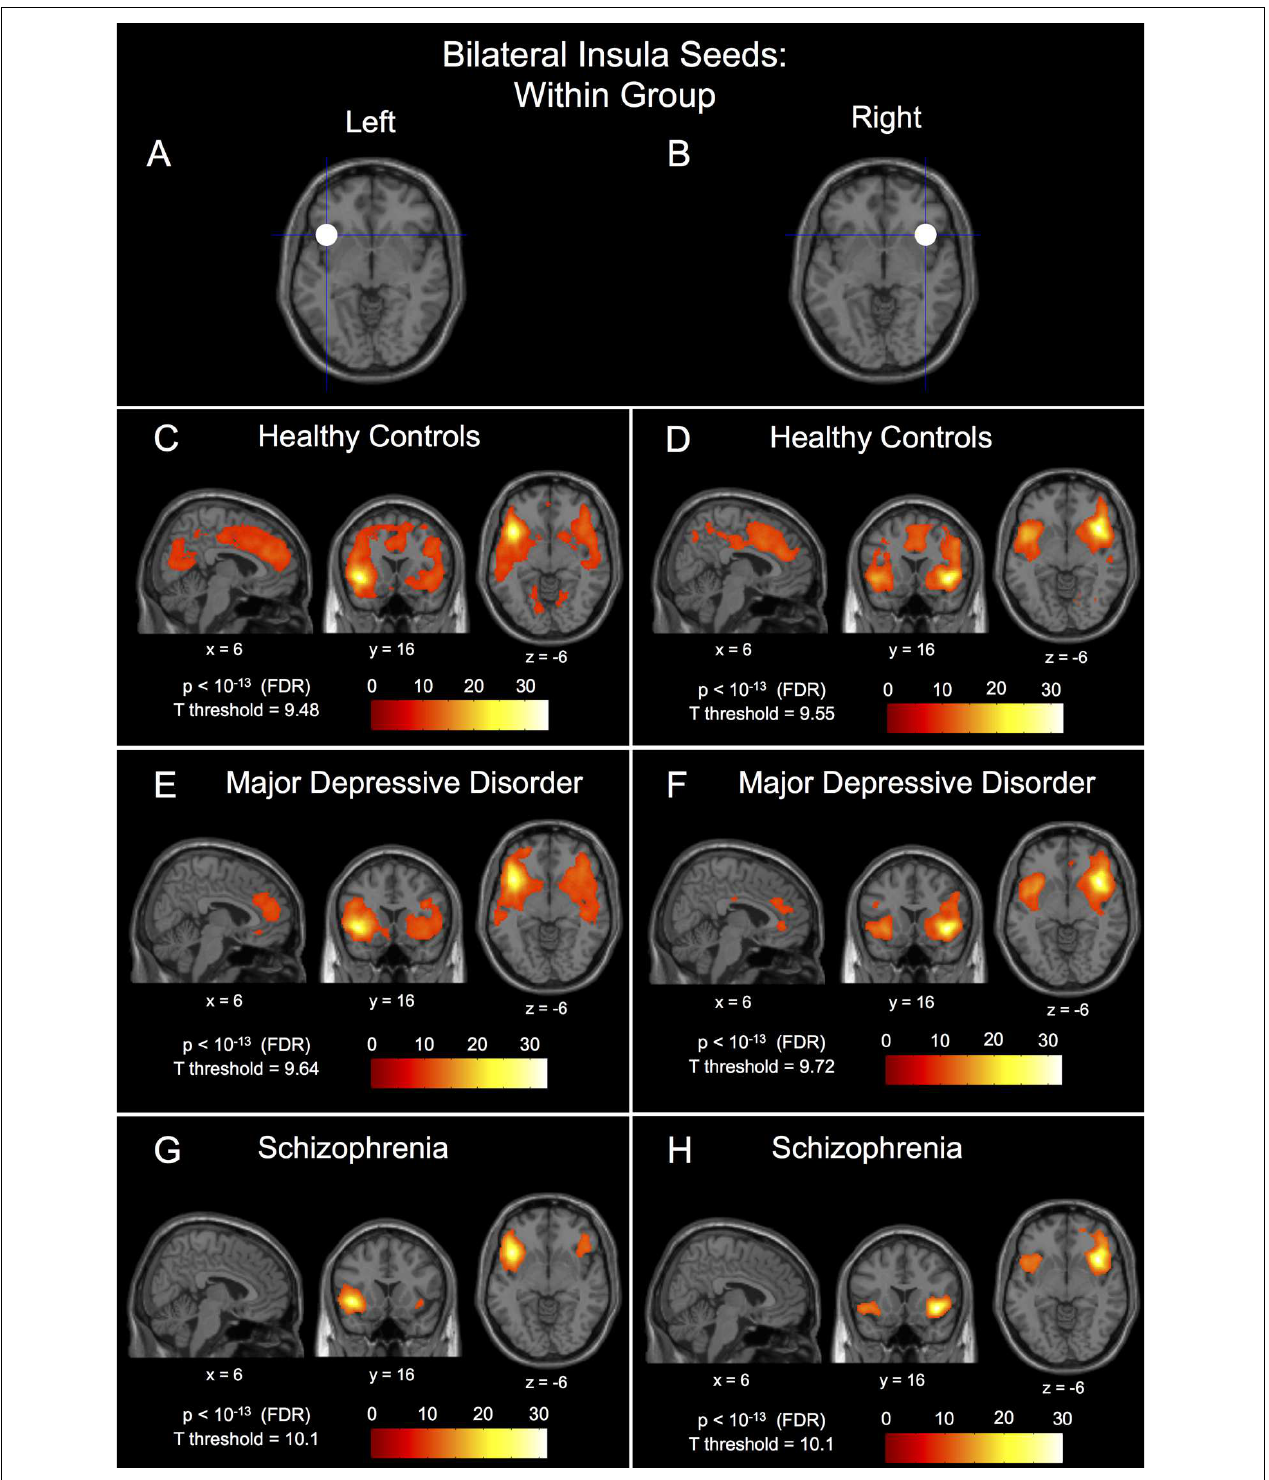
FIGURE 2 | Within-group connectivity to the bilateral insula seeds in healthy controls, major depressive disorder patients, and schizophrenic patients. The 10 mm radius left insula seed centered at ( − 40, 18, − 4) shown in (A) and it’s within-group connectivity shown below for healthy controls in (C) , major depressive disorder patients in (E) , and schizophrenic patients in (G) . The 10 mm radius right insula seed centered at (40, 18, − 4) shown in (B) and it’s within-group connectivity shown below for healthy controls in (D) , major depressive disorder patients in (F) , and schizophrenic patients in (H) . Seed coordinates and image labels are in MNI space. All p -value thresholds were set for display purposes